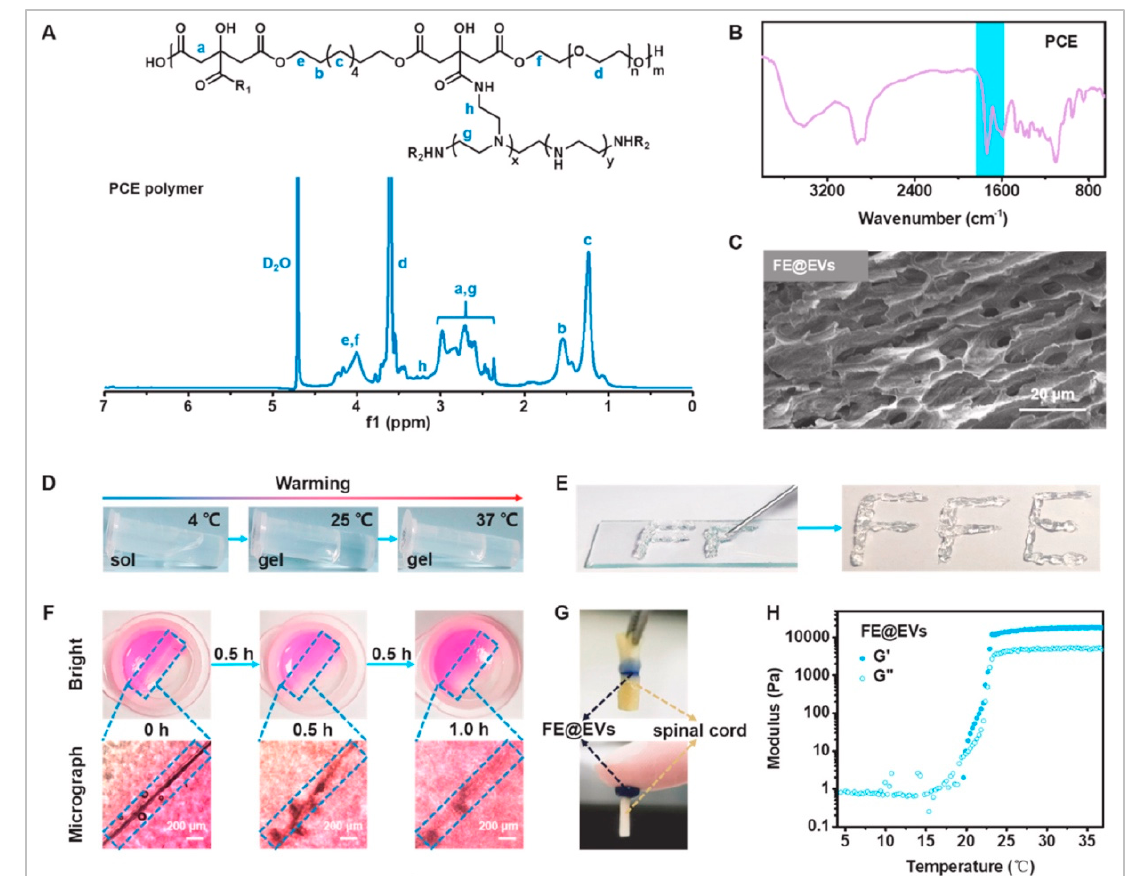
Figure 3. Physicochemical structure and multifunctional properties of the FE@EVs hydrogel. ( A ) 1 H NMR spectra of the PCE polymer; ( B ) FTIR spectra of the FE hydrogel; ( C ) SEM image of the FE@EVs hydrogel. ( D ) The sol–gel transition of the FE@EVs hydrogel with temperature changes. ( E ) The photographs of the FE@EVs hydrogel through the needle. ( F ) The photographs of the FE@EVs hydrogel placed for a while after being cut off (hydrogel in blue dottex box). ( G ) The photographs of the FE@EVs hydrogel adhering to spinal cord (black arrow: FE@EVs, green arrow: spinal cord). ( H ) The G (cid:48) and G” changes of the FE@EVs hydrogel at 4–38 ◦ C. Reprinted with permission from